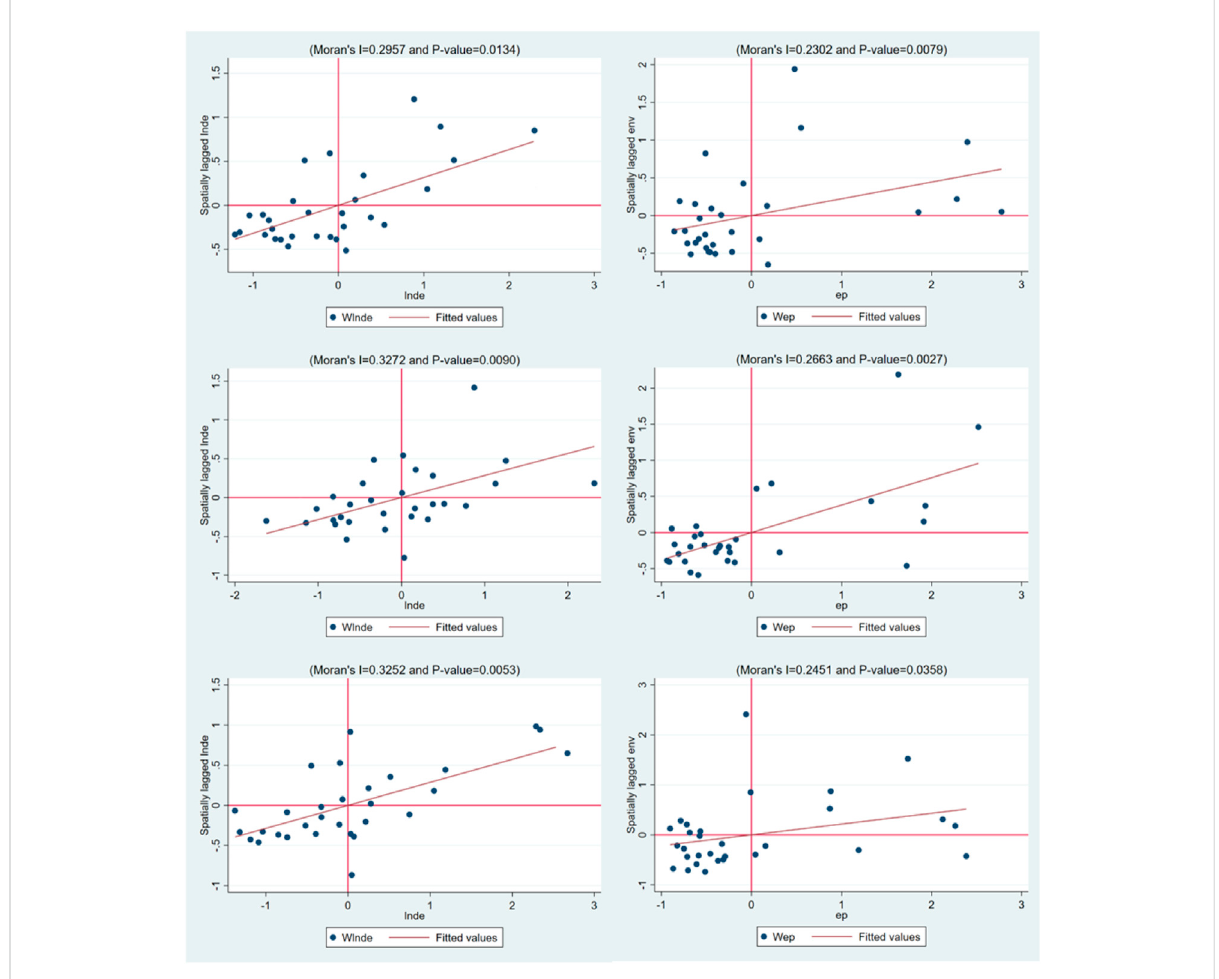
FIGURE 7 Moran scatter of ep and lnde in 2013, 2016, and 2019. Note: the variable on the left is the digital economy, and the variable on the right is ecological performance. From top to bottom, the years of each picture are 2013, 2016, and 2019.